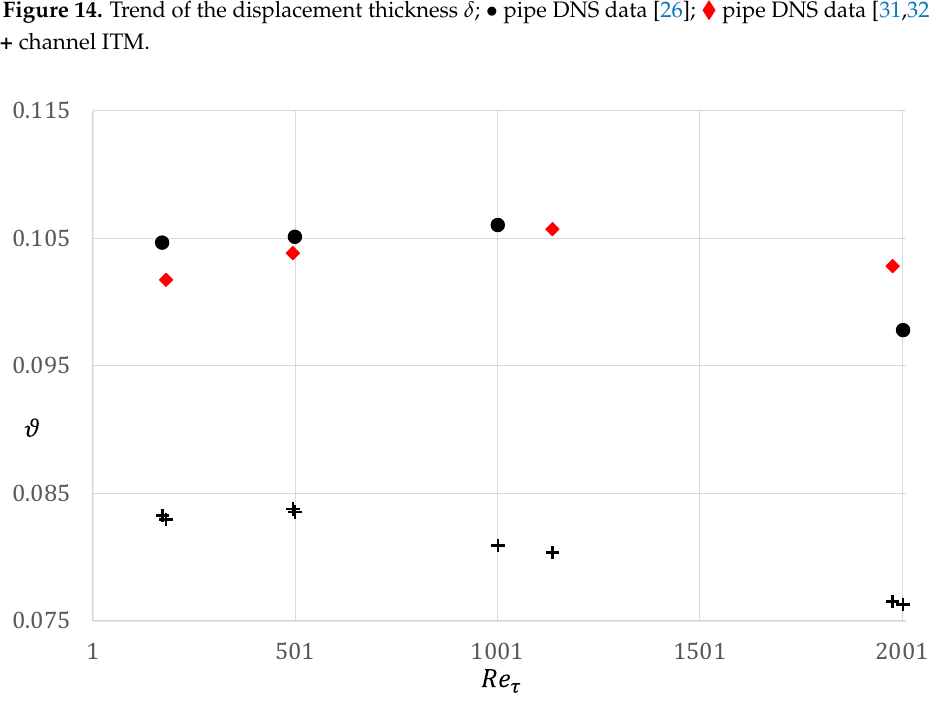
; • pipe DNS data [26]; pipe DNS data [31,32]; and ♦ 𝜗𝜗